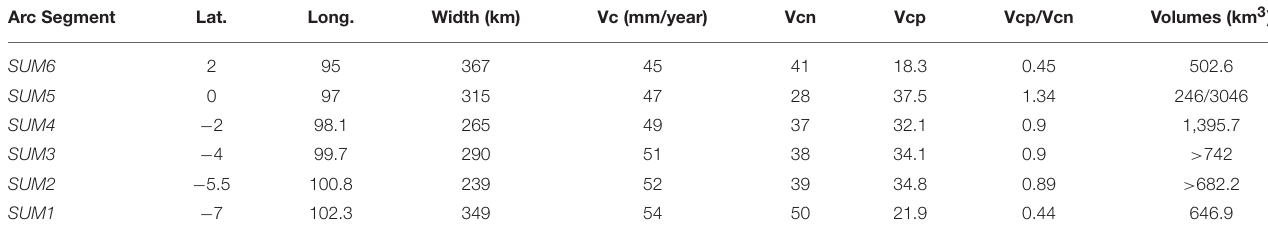
TABLE 2 | Location (lat., long. and width), velocity of convergence (total convergence Vc, normal and parallel convergences, Vcn and Vcp, respectively, all in mm/yr) and erupted volumes (see Table 1 ) of segments of the volcanic arc of Sumatra, as proposed in Heuret and Lallemand (2005) and Lallemand et al. (2005). Arc Segment Lat.